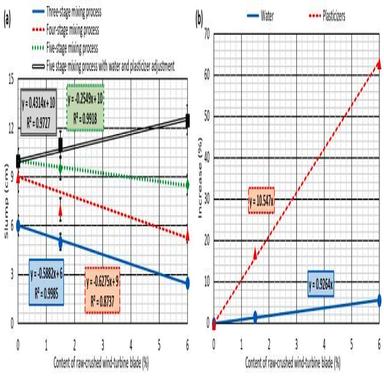
Fresh performance of concrete mixes with RCWTB: (a) slump; (b) water and plasticizer adjustment.